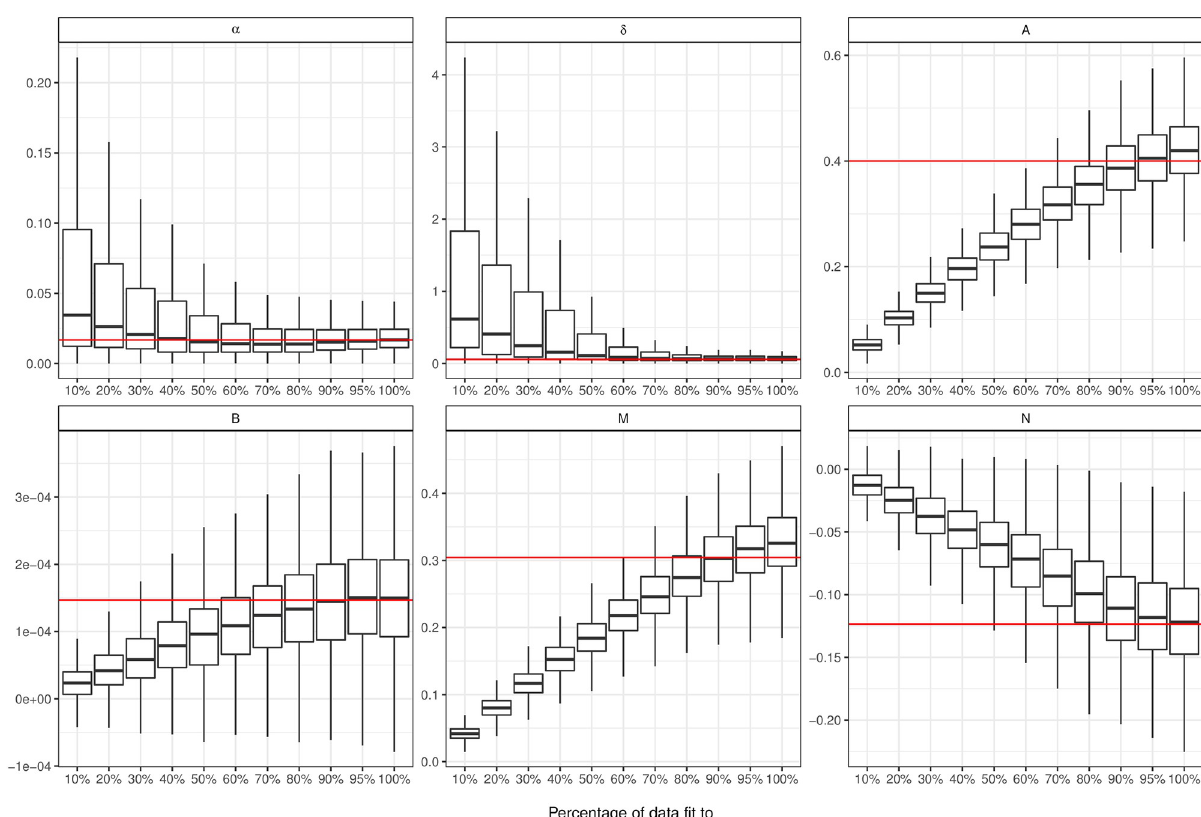
Fig 3. Box and whisker plots showing the distribution of our fits to different proportions of the data. Each of the parameters in our model is shown as a different plot. The red line is the true parameter used to generate our simulations and the box shows the interquartile range with the whiskers showing 1.5 times the interquartile range above and below the 25th and 75th